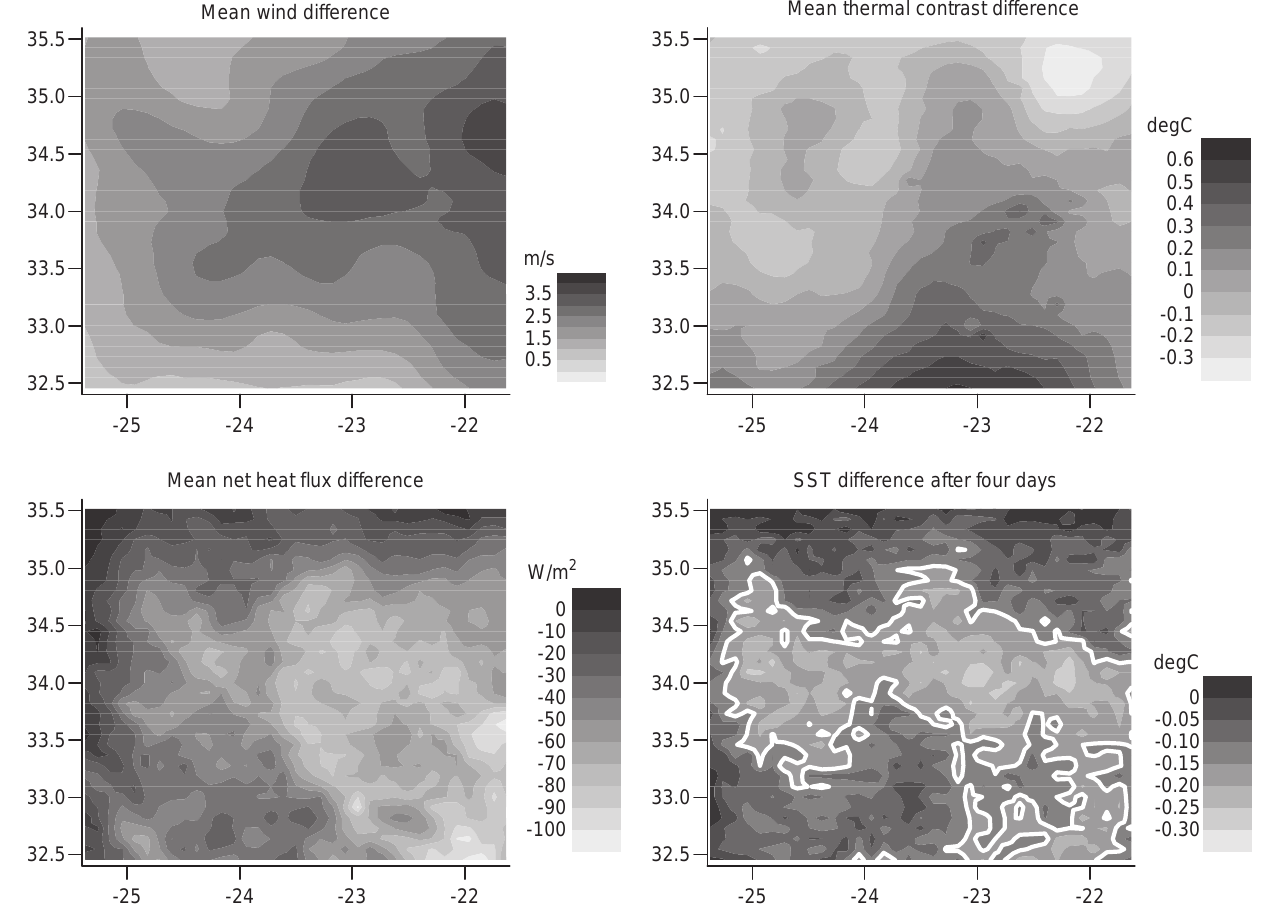
Fig. 9. From top to bottom and from left to right: wind, ocean-atmosphere thermal contrast, net heat flux and SST di(cid:128)erences between the coupled and forced oceanic